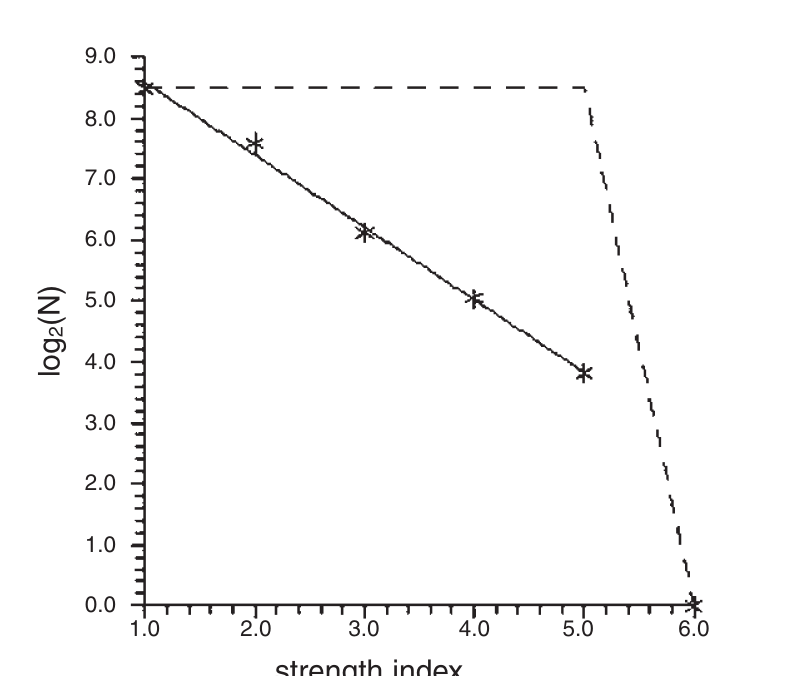
Fig. 2. Cumulative distribution of the logarithm of the number of El Niño events since 1950 versus their strength index ( SI ). The dashed line represents the relative random